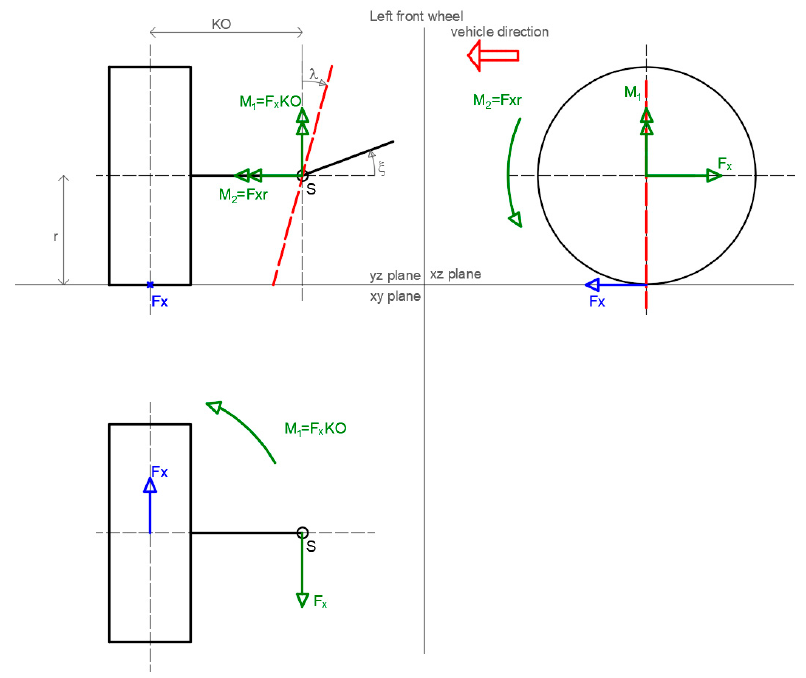
Figure 5. Case 3: inclined half shaft.